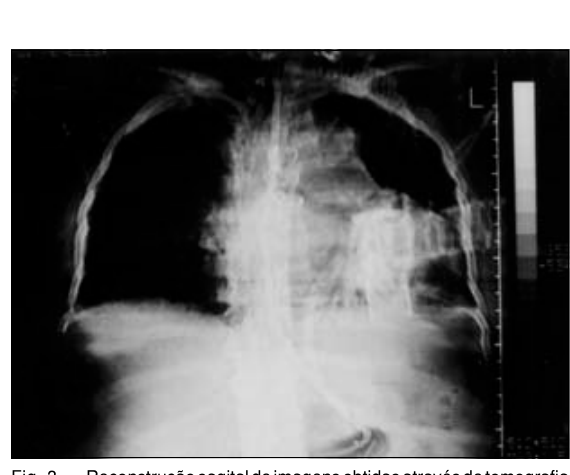
Fig. 3 - Reconstru(cid:231)ªo sagital de imagens obtidas atravØs de tomografia computadorizada, mostrando eleva(cid:231)ªo e retifica(cid:231)ªo das cœ- pulas frŒnicas, sugerindo paralisia frŒnica